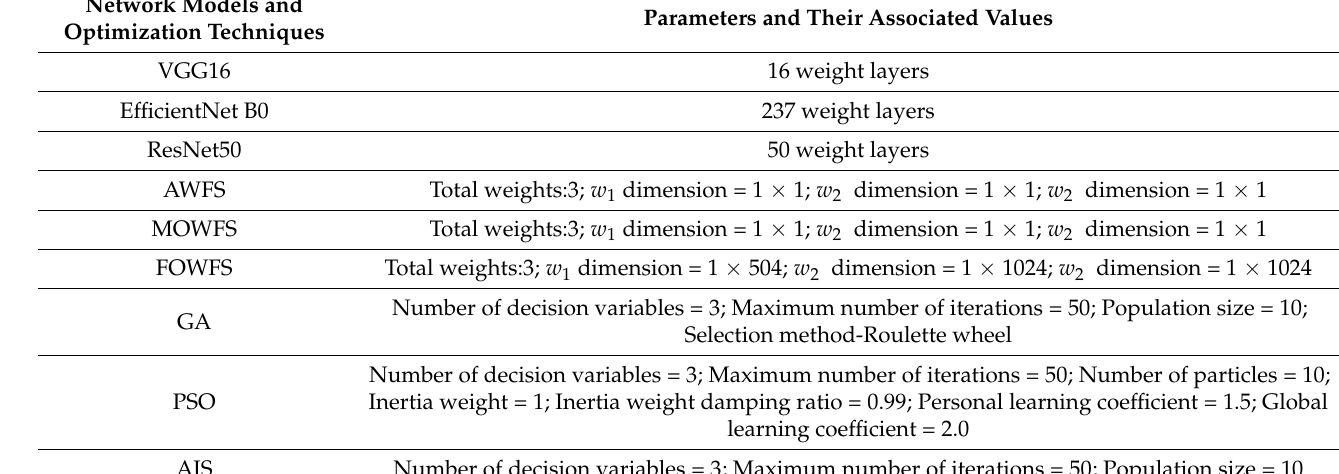
Table 2. Parameters and their chosen